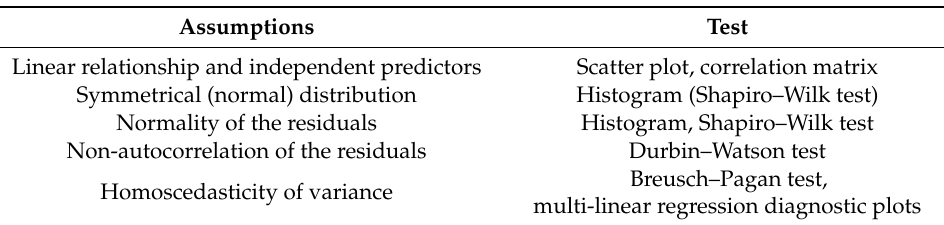
Table 3. Multi-linear model assumption